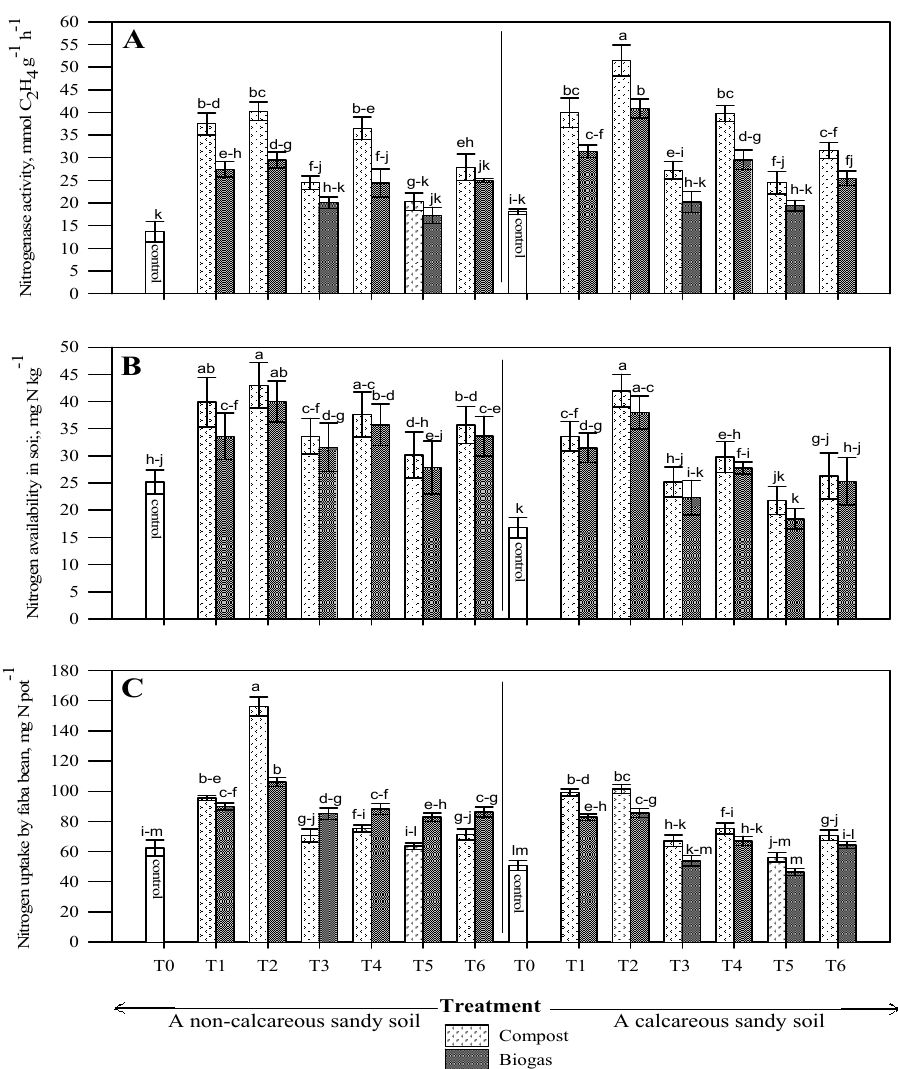
Figure 2. Nitrogenase activity within the rhizosphere ( A ), N-availability in soil ( B ) and uptake ( C ) by faba bean plants as affected by application of organic and mineral N-fertilizers, either solely or in different combinations (mean ± SD). For treatments from T0 to T6, see footnote Figure 1. Different letters indicate significant variations among treatments.